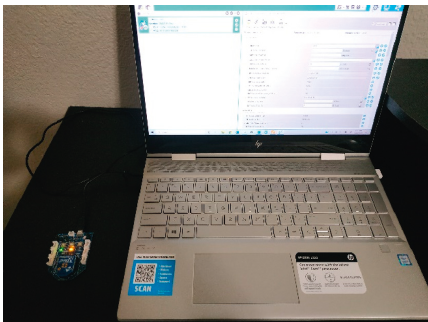
Figure 2: Interfacing XBee module to the XCTU via USB